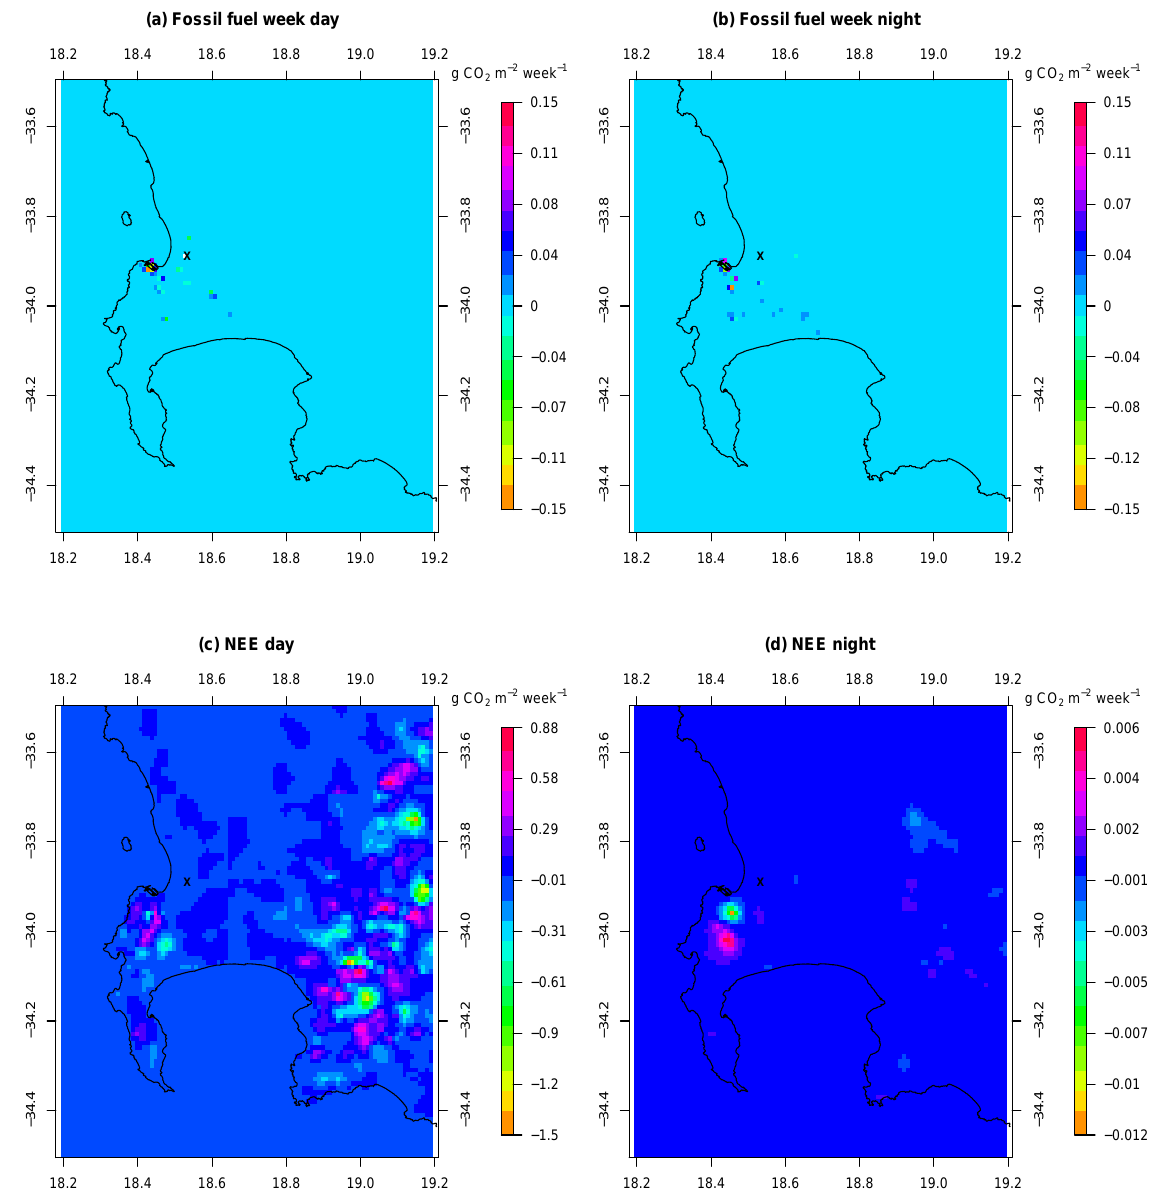
Figure 15. Posterior covariances (g 2 CO 2 m − 4 week − 2 ) between the uncertainty in the fossil fuel working week daytime flux during the first week of March 2012 in the selected pixel (marked by X) and (a) all other fossil fuel working week daytime fluxes; (b) fossil fuel working week night-time fluxes within this pixel and all other pixels; (c) NEE daytime fluxes within this pixel and all other pixels; (d) NEE night-time fluxes within this pixel and all other pixels. Extent: between 34.5 and 33 . 5 ◦ S and between 18.2 and 19 . 2 ◦